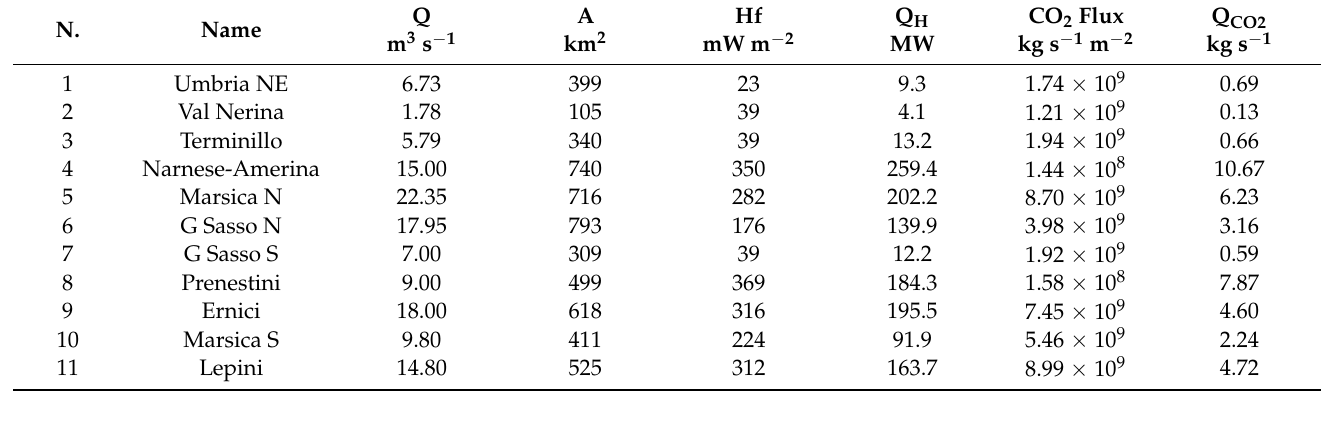
Table 4. Main hydrogeological parameters of the aquifers (total flow rate Q and surface area of the hydrogeological basin A) and results of the carbon mass and enthalpy balances (Hf, Q H , CO 2 flux, Q CO2 ). Data are from [17]. N.